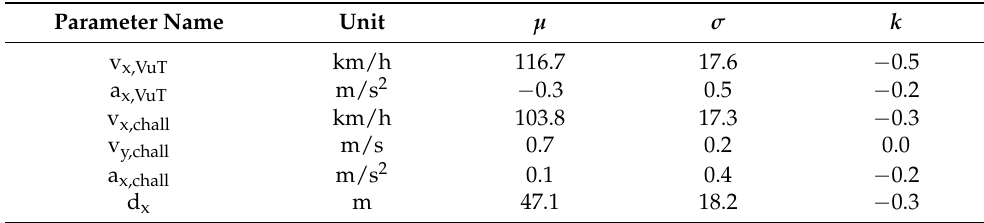
Table 3. Fitted distributions for exposure data subset (based on 2065 cut-in scenarios).